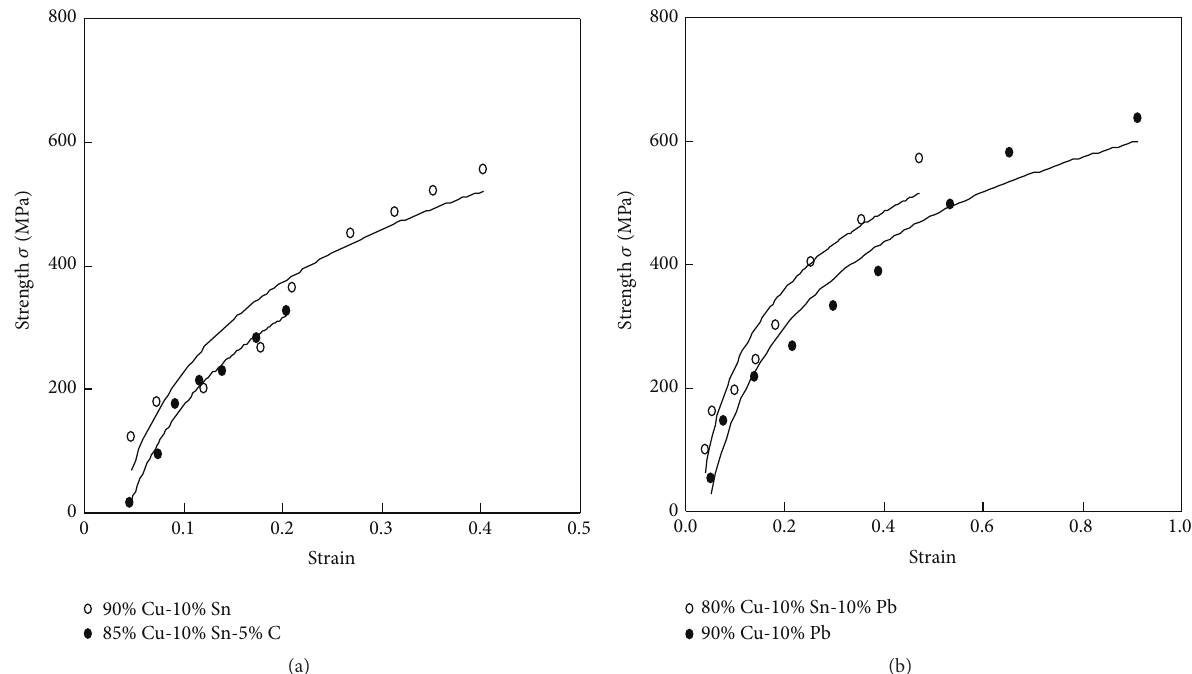
Figure 8: The stress-strain curves for the heat-treated (a) 90% Cu-10% Sn and 85% Cu-10% Sn-5% C and (b) 80% Cu-10% Sn-10% Pb and 90% Cu-10% Pb alloys.